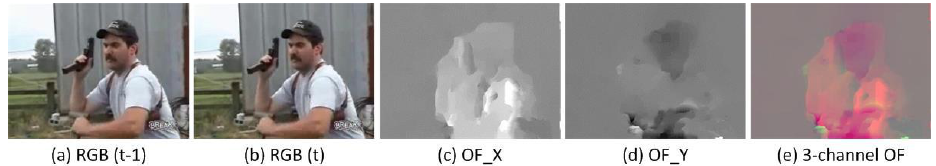
Figure 3. Two consecutive frames, optical flow in the horizontal and vertical directions and 3-channel optical flow.